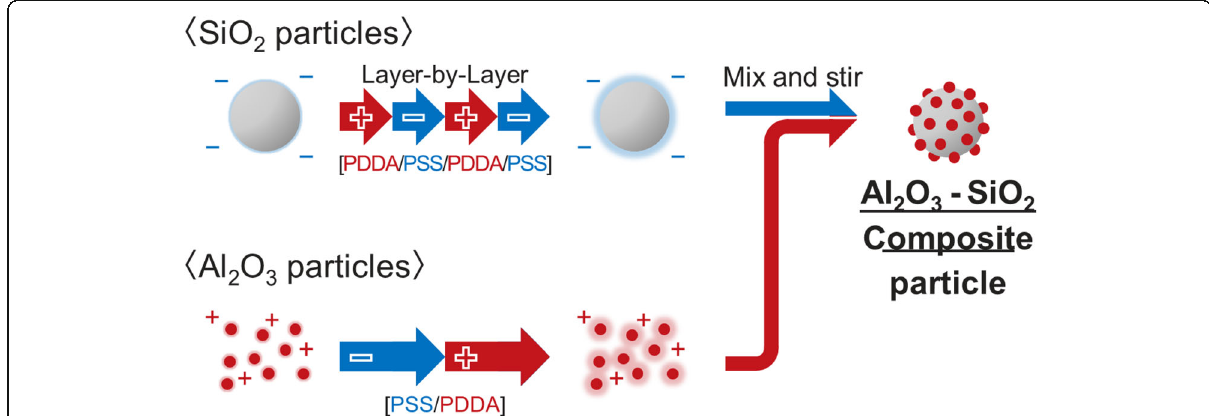
Fig. 3 Schematic of a Al 2 O 3 -SiO 2 composite particle formation after layer-by-layer coating process of PDDA and